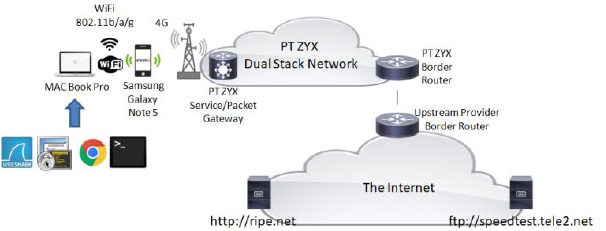
Fig. 7. Connectivity test environment